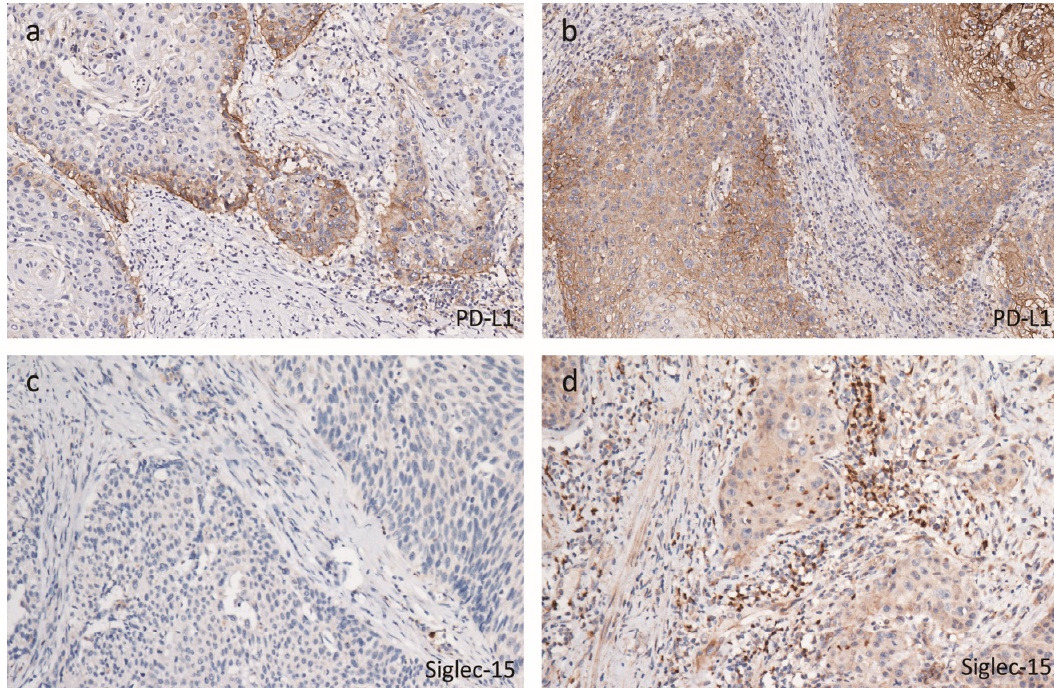
Figure 1. The expression of PD-L1 and Siglec-15 in peSCC tissues by immunohistochemistry. Representative immunohistochemistry (IHC) images show marginal ( a ) and diffuse ( b ) expression of PD-L1 expression ( b ). The low ( c ) and high ( d ) expressions of Siglec-15 in intratumoral or stromal tumor-infiltrating myeloid cells were also presented. Magnification: 200×.